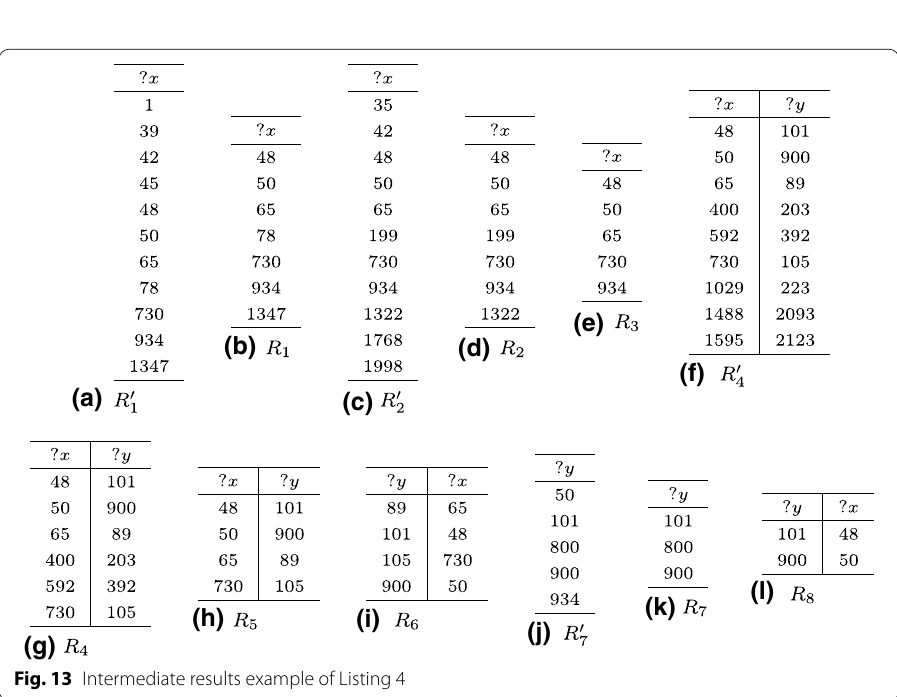
Fig. 13 Intermediate results example of Listing